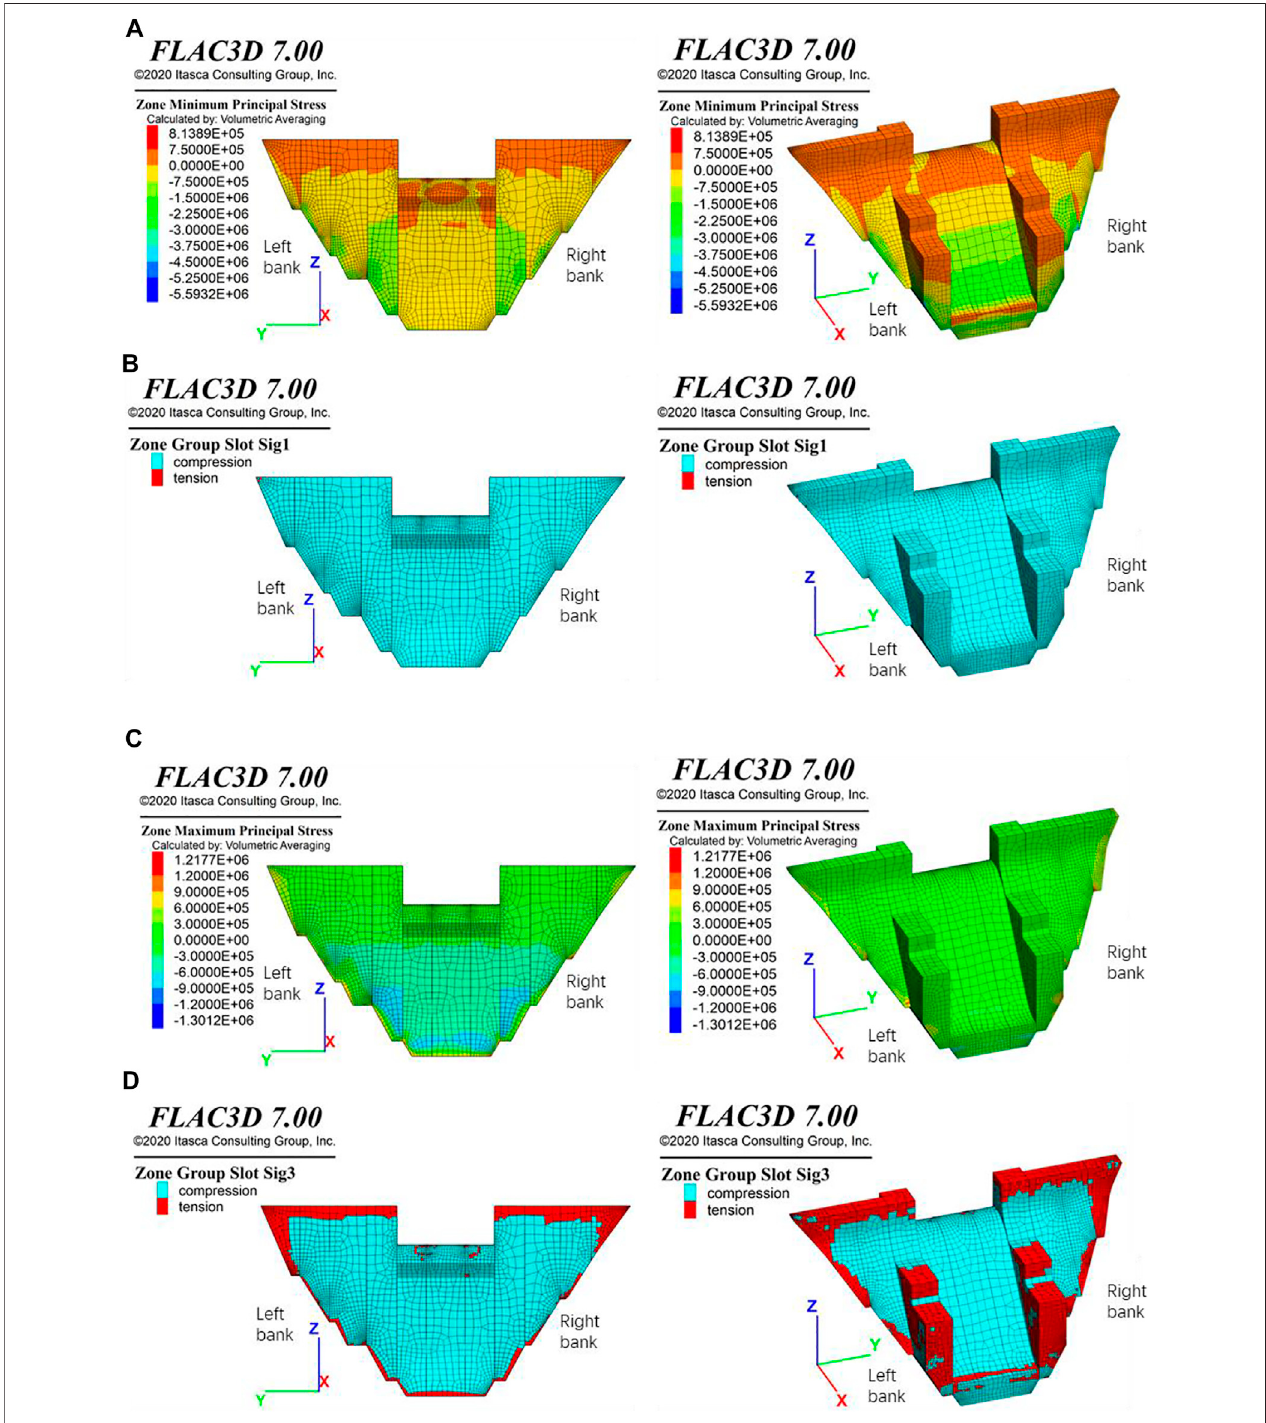
FIGURE5|(A) Distributionofmajorprincipalstress. (B) Tensilezonesofthemajorprincipalstress. (C) Distributionofminorprincipalstress. (D) Tensilezonesofthe minor principal stress (left sub fi gures: upstream view, right sub fi gures: downstream view).